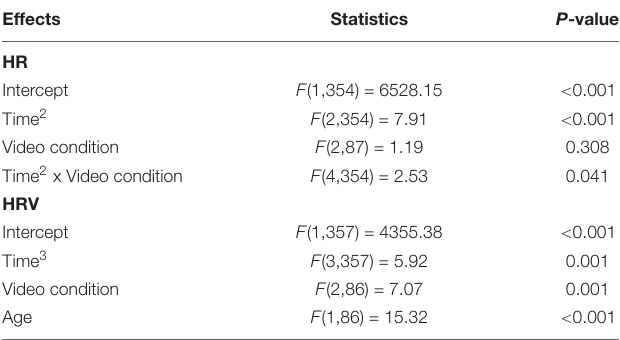
TABLE 4 | Summary of final model to predict HR and HRV in Study